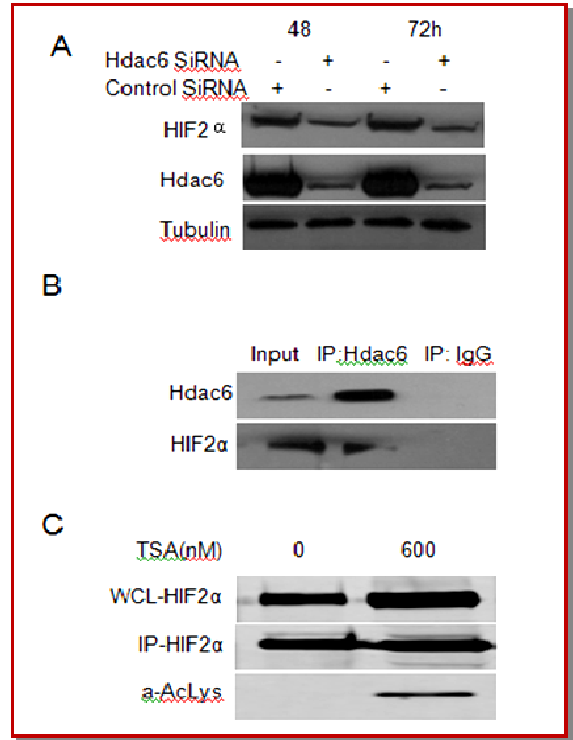
Figure 4: HDAC6 is involved in regulation of HIF-2 α degrada- tion and HIF-2 α is acetylated by TSA (A) siRNA against HDAC6 and control siRNA were transfected into MG-63 cells at 50 nM. At 48 and 72 hours after transfection, cells were exposed to hypoxia for 8 hours, and cell extracts were subjected to western blot assay for HIF-2 α, HDAC6 and tubulin. (B) MG-63 cells were treated for 8 hours in hypoxia (1%O 2 ), and cell extracts were im- munoprecipitated with antibody against either HDAC6 or control IgG. The immunocomplexes were detected for HDAC6 and HIF-2 α by west- ern blot assay, and 20 µg of cell extracts without immunoprecipitation served as a control. (C) MG-63 cells were exposed to hypoxia (1%O 2 ) and MG132 (5 μ M) for 6 hours with or without 600 nM TSA, and cell lysates were immunoprecipitated with anti-HIF2 α antibody. Cell lysates and immunocomplexes were immunoblotted with anti-HIF-2 α and anti- acetyl-lysine (a-AcLys)